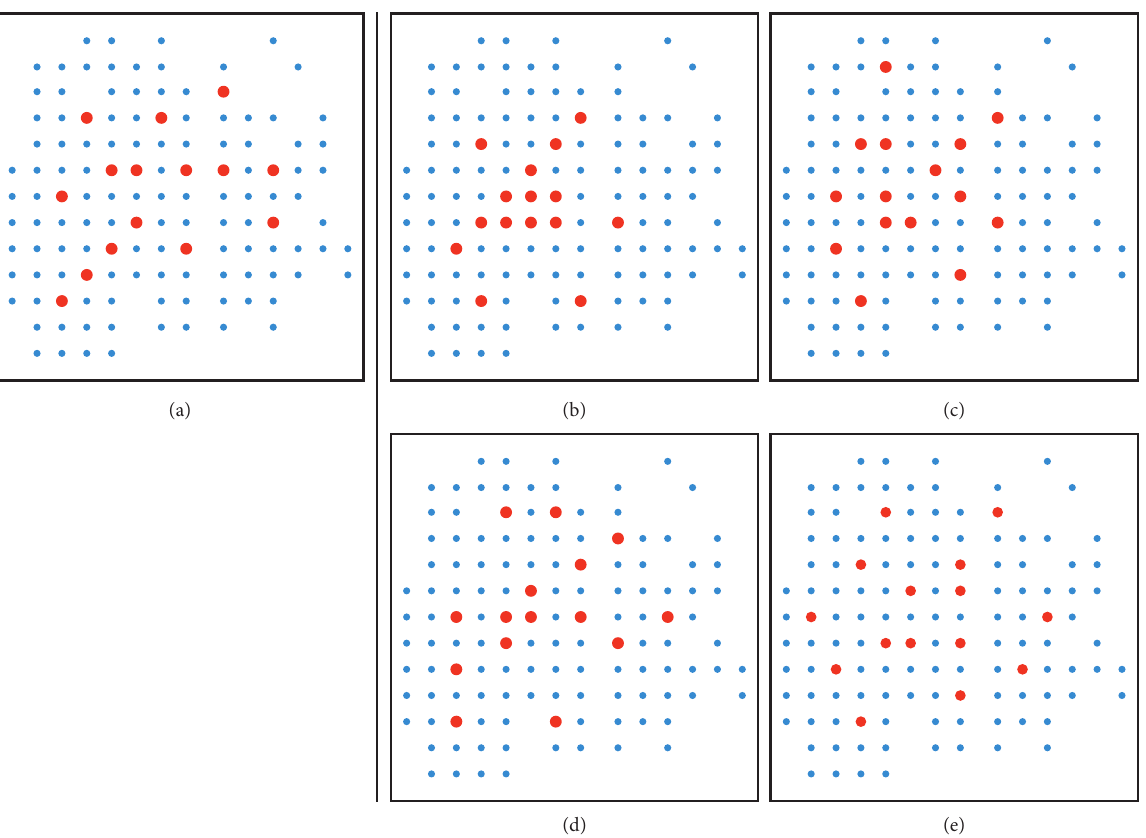
Figure 9: Optimal hub locations of scenario B: (a) 0%, 9.45km, i.e., hub location of the metro-truck network without taxis. (b) 25%, 7.16km, (c) 50%, 8.13km, (d) 75%, 8.85km, and (e) 100%,